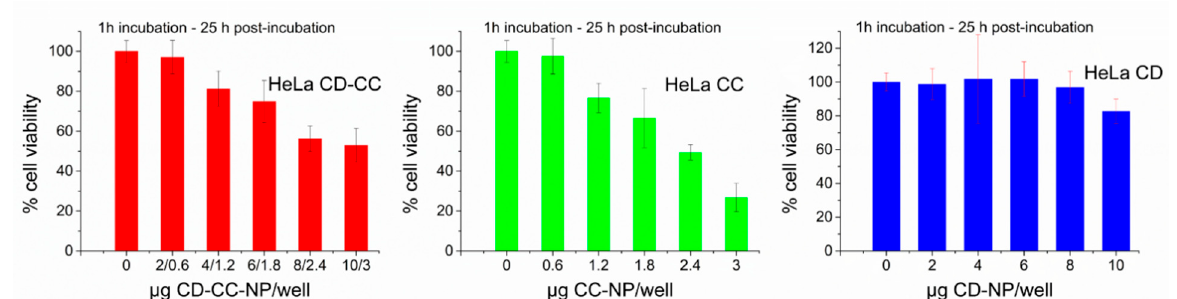
Figure 8. CCK-8 cell viability analysis of HeLa cells incubated with CD-CC-NP (CD:CC 1:1, red), DMSO-derived pure CC-NP (green) and the free carrier CD-NP (blue), incubation time 1 h, analyzed at 20 h post-incubation.